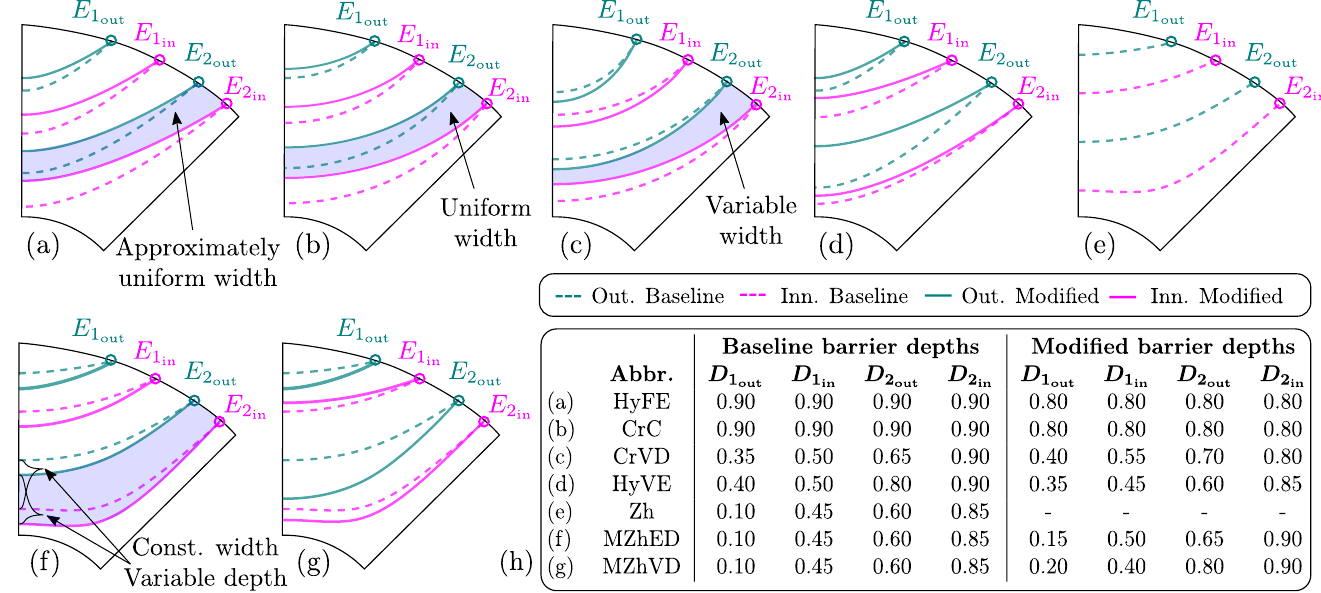
Figure 5. Barrier depth variation influence on different 2-barrier ( k = 2) SyRM topologies (depth coefficient table is